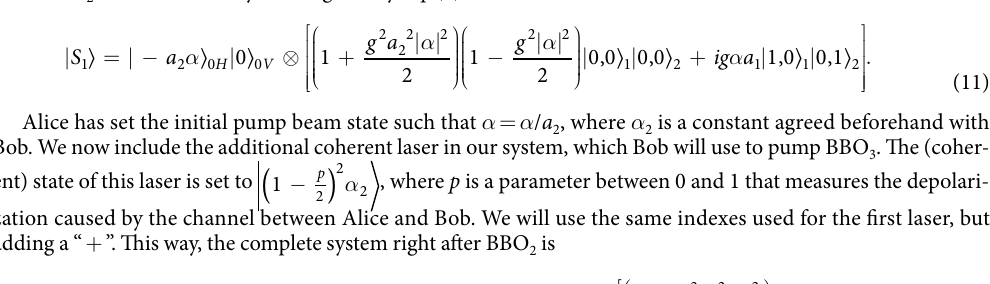
probability for this process to fail, when the pair of states W 3 0